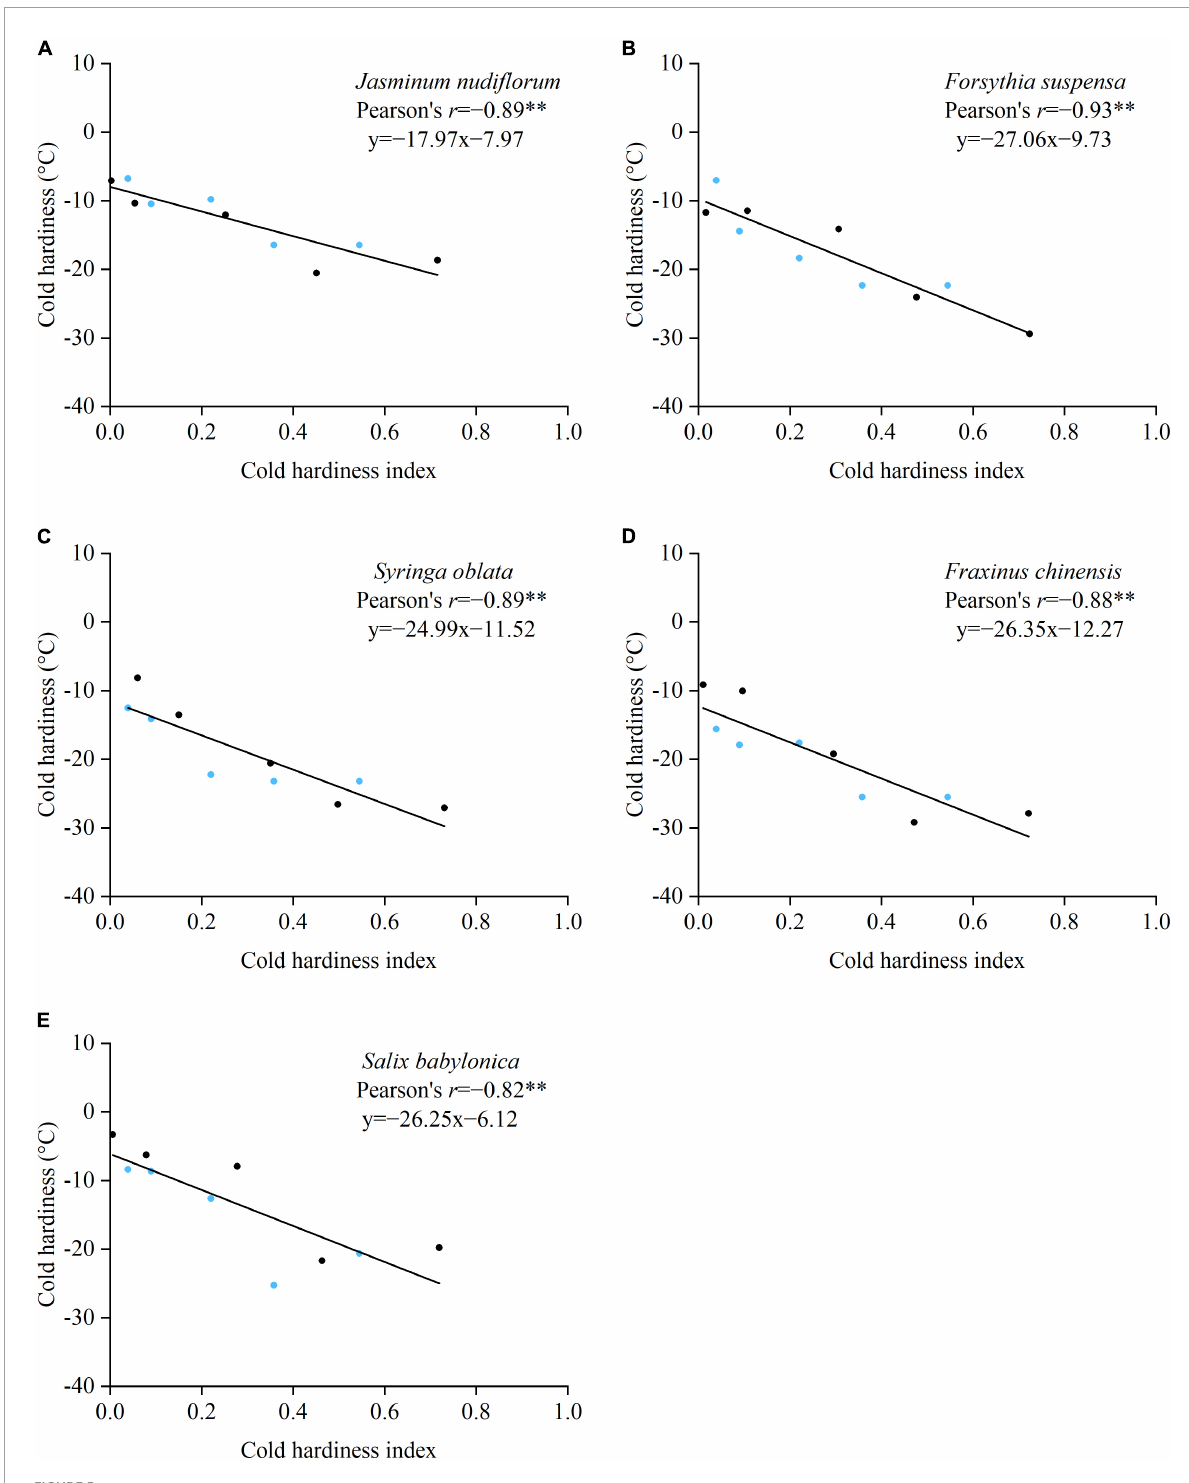
FIGURE5 Relationships between cold hardiness measured with the electrical conductivity method and cold hardiness index estimated from Equation 8 for five species. Blue dots: samples in the process of cold acclimation. Black dots: samples in the process of deacclimation. ∗∗ p < 0.01. (A) J. nudiflorum , (B) F. suspensa , (C) S. oblata , (D) F. chinensis , and (E) S. babylonica